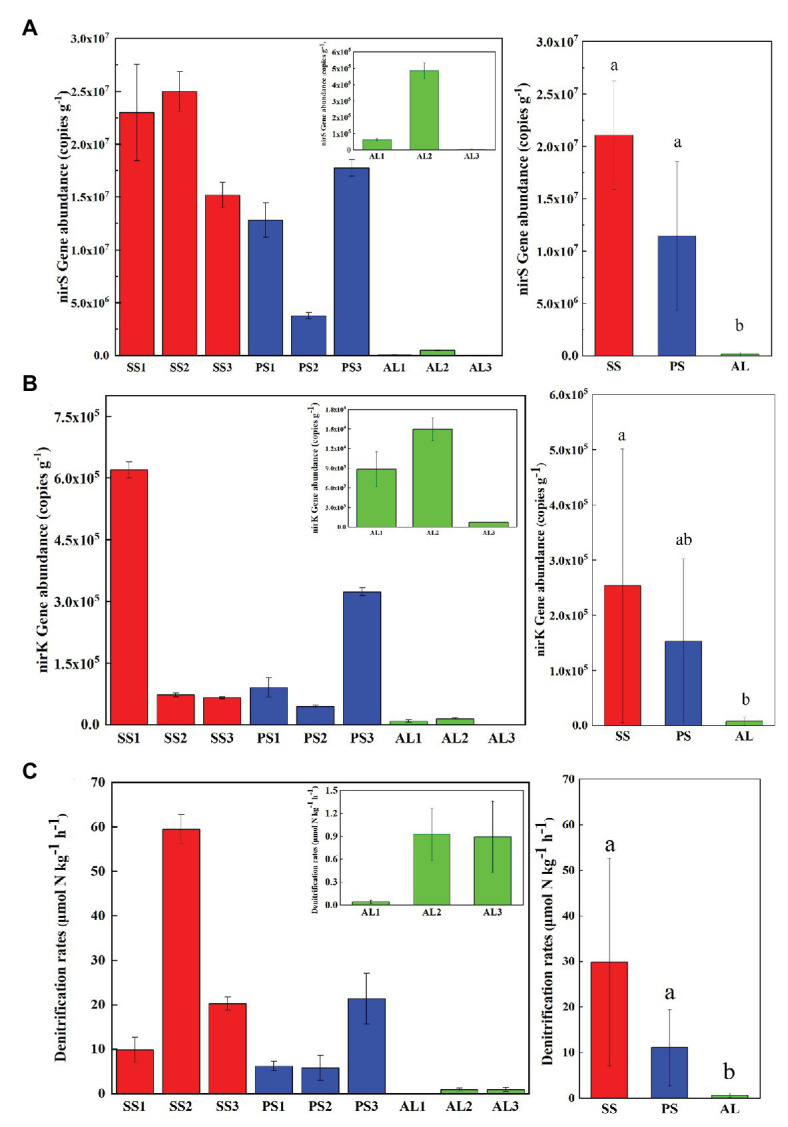
Comparisons of the abundances of nirS (A) and nirK (B) genes, and denitrification rates (C) in tundra soils of maritime Antarctica. Left figures presented the mean abundances of nirS (A) and nirK (B) genes, and the mean denitrification rates (C) in the soils of individual tundra site; Right figures indicated the mean abundances of nirS (A) and nirK (B) genes, and the mean denitrification rates in seal colony soils (SS), penguin colony soils (PS), and animal-lacking tundra soils (AL). The different letters indicated statistically significant differences (ANOVA, p < 0.05). The error bars indicate standard deviations of the averages.